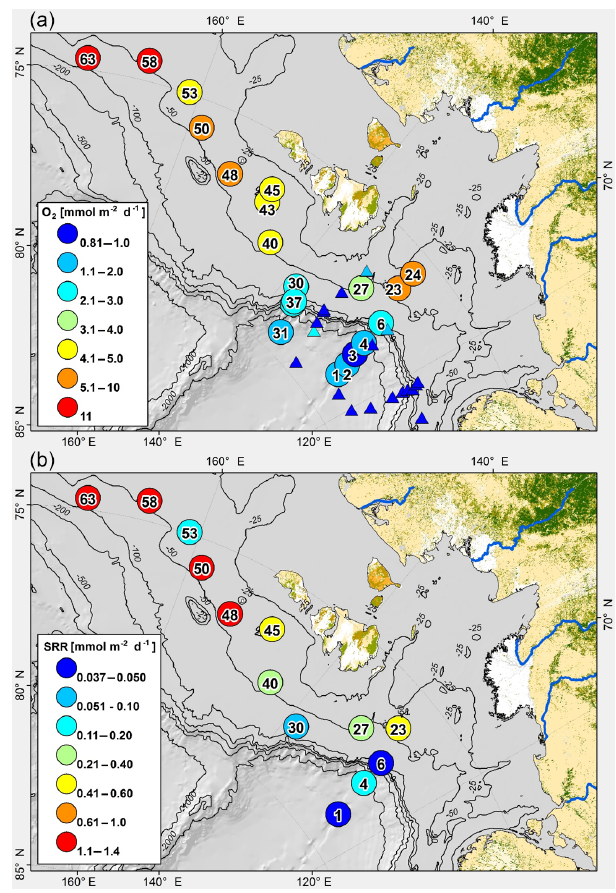
Figure 8. (a) Map of field area and sampling stations showing oxy- gen uptake rates. For comparison, oxygen uptake rates reported in Boetius and Damm (1998) are shown as triangles using the same color code. (b) Map of field area and sampling stations with depth- integrated sulfate reduction